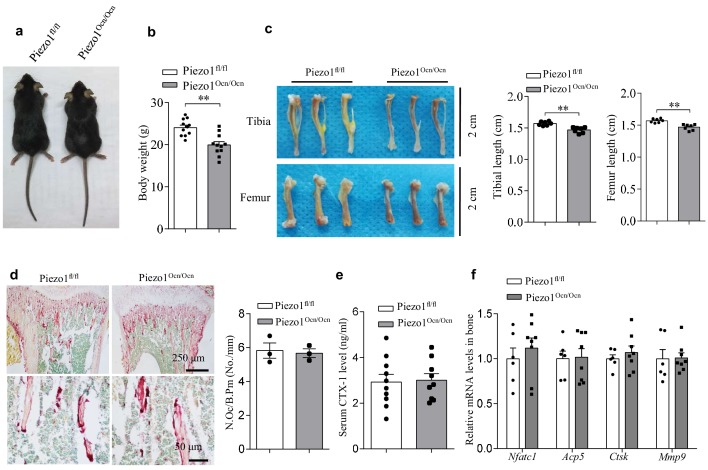
The phenotypes of Piezo1fl/fl and Piezo1Ocn/Ocn mice.(a) The appearance and body length of 2-month-old Piezo1fl/fl and Piezo1Ocn/Ocn mice. (b) The body weight of Piezo1fl/fl (n = 11) and Piezo1Ocn/Ocn mice (n = 11). (c) The appearance and the length of femurs and tibias from Piezo1fl/fl (n = 7) and Piezo1Ocn/Ocn mice (n = 7). (d) Representative images of Trap staining in bone tissue from Piezo1fl/fl and Piezo1Ocn/Ocn mice. N.Oc/B.Pm, osteoclast number/bone perimeter. (e) ELISA analysis of the levels of CTX-1 protein level in the serum from Piezo1fl/fl (n = 10) and Piezo1Ocn/Ocn mice (n = 9). (f) QRT-PCR analysis of Nfatc1, Acp5, Ctsk and Mmp9 mRNA levels in bone tissue from Piezo1fl/fl (n = 6) and Piezo1Ocn/Ocn mice (n = 8). All data are the mean ± s.e.m. **, p<0.01.